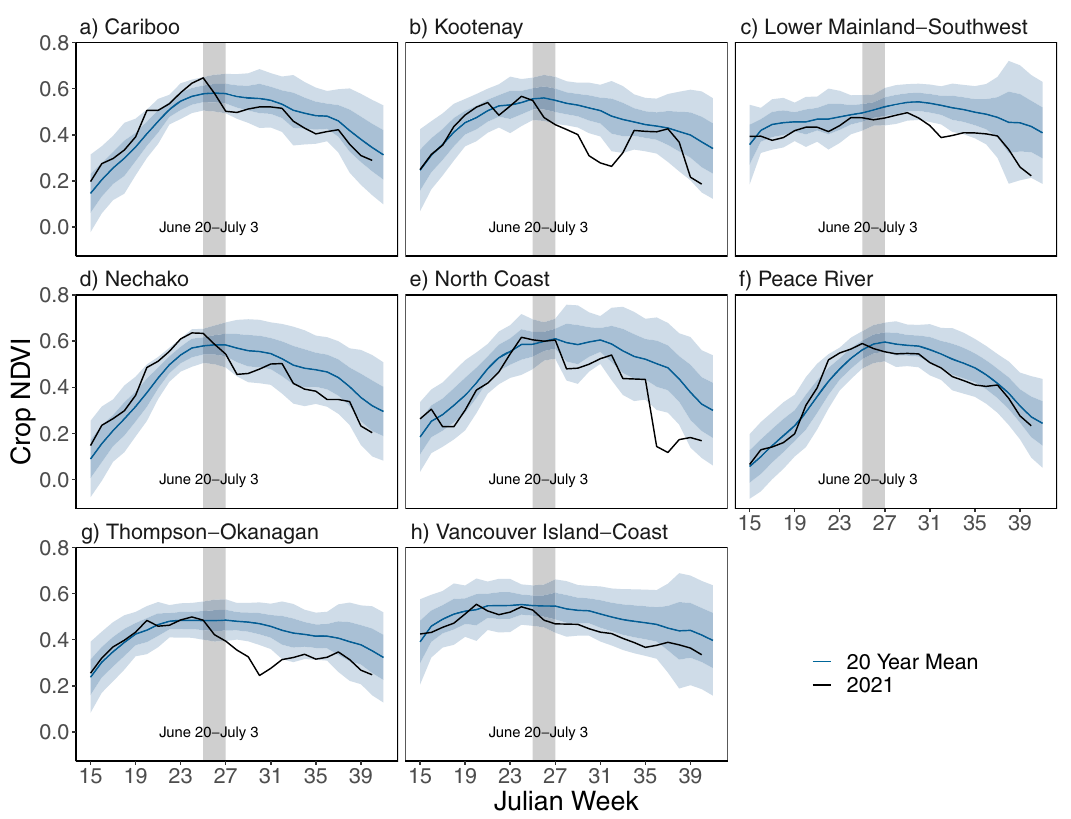
Fig. 8 | Heatwave impacts on crop health. Weekly Normalized Difference Vege- tation Index (NDVI) from the Crop Condition Assessment Program (see Methods), spatially averaged over agricultural divisions in British Columbia, organized alphabetically. 2021 values are shown in the black line, with the 2000 – 2020 cli- matology in blue and shading showing interannual variability for this 2000 – 2020